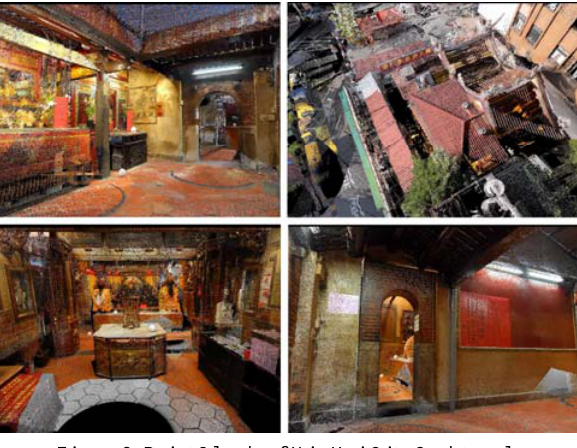
Figure 8. Point Clouds of Xia-Hai City God